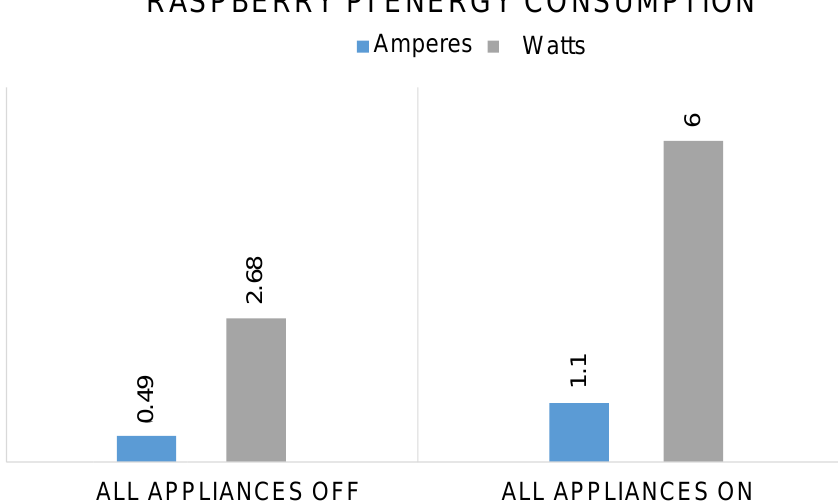
Figure 11. Total energy consumption of RPI in terms of amperes, and watts when all the appliances are turned ON.